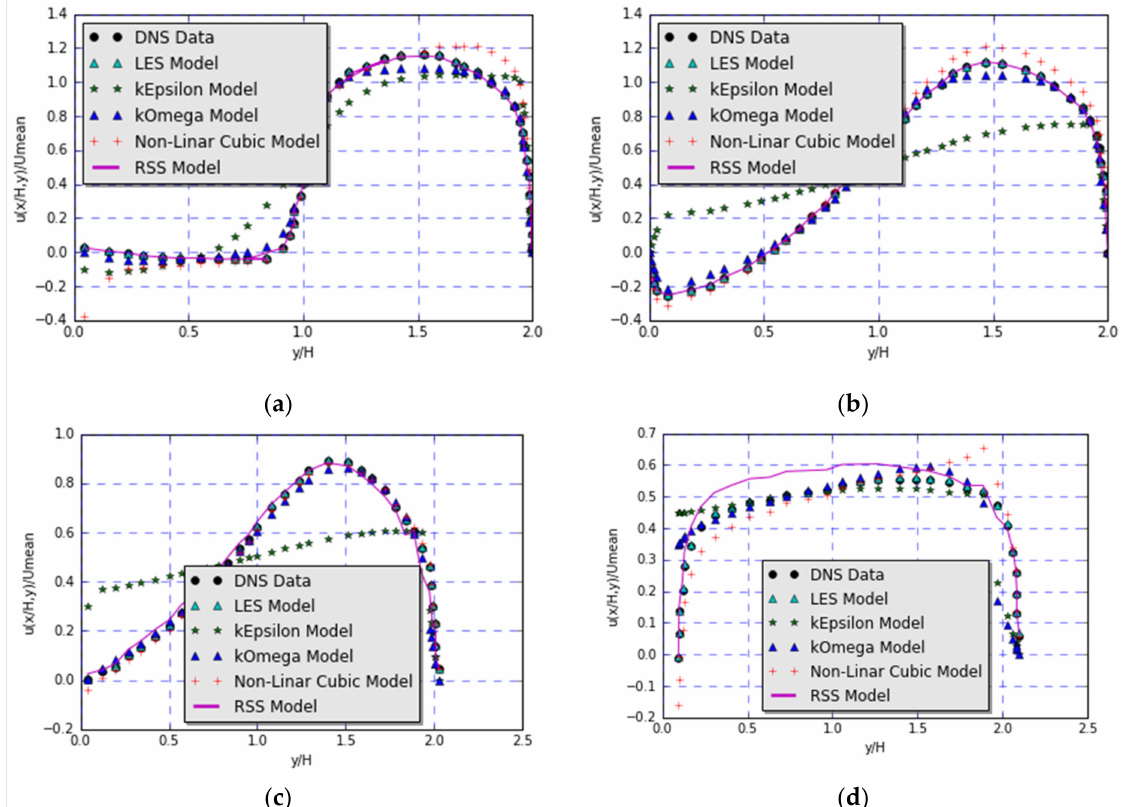
Figure 5. Comparison of different turbulence models compared against the DNS simulations (LES with multiple-gradients, RANS standard k − (cid:101) model, RANS Wilcox k − ω model, nonlinear RANS turbulence model and RANS RSS transport model) for Re = 9000 ( a ) x / H = 0.5; ( b ) x / H = 4.0; ( c ) x / H = 8.0; ( d ) x / H =